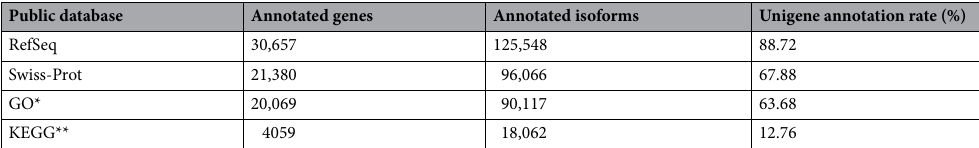
Table 1. Functional annotation of 43,920 potential genes (141,513 putative isoforms) against four public databases. *At least in one of the three main categories of GO terms (biological process, molecular function and cellular component); **Metabolic